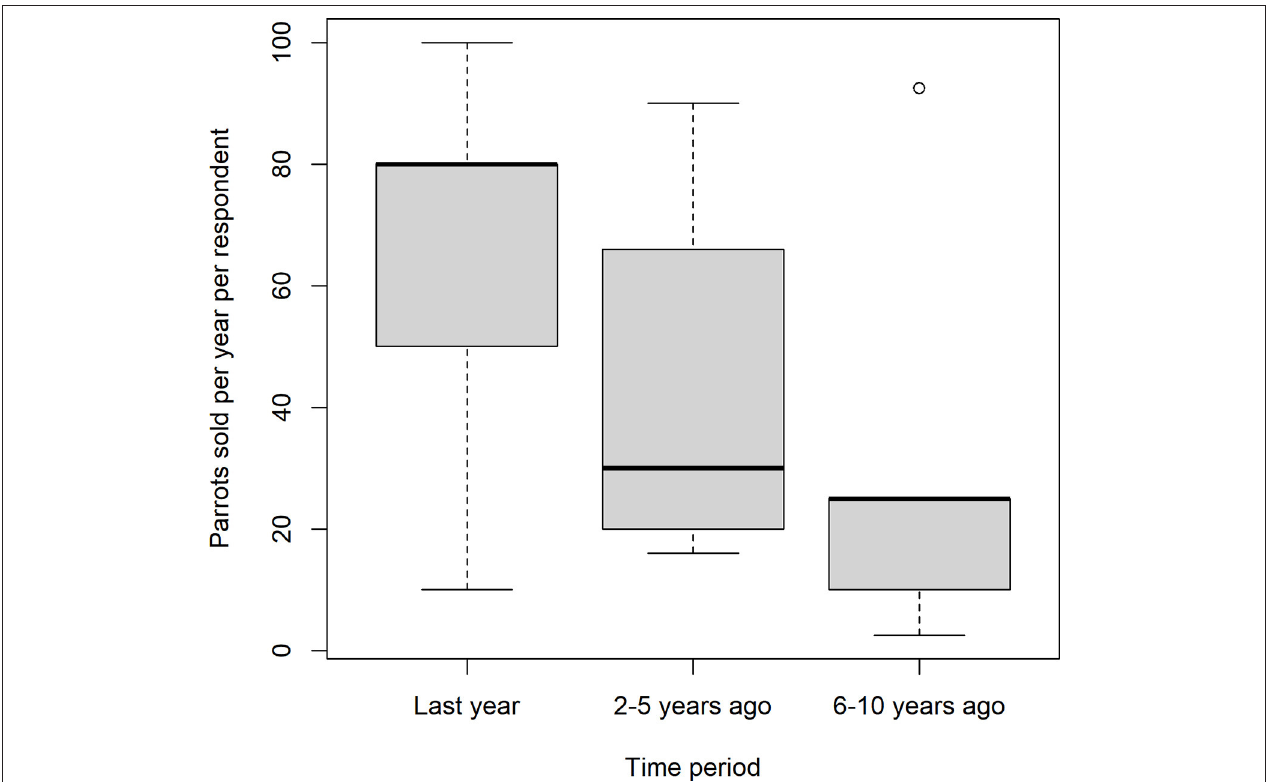
FIGURE 1 | Number of Grey parrots ( Psittacus erithacus ) sold per year per respondent across three periods [last year (2017), two to five years ago (2013–2016), and six to ten years ago (2008–2012)]. One-way ANOVA revealed no significant difference in the number of Grey parrots sold (per vendor, per year) across the three different time periods ( F = 0.98, df = 2, 12, p = 0.404). Pairwise Tukey post-hoc testing also revealed no significant differences between time periods (2017: P = 0.43; 2013–2016: P = 0.52; 2008–2012: P =